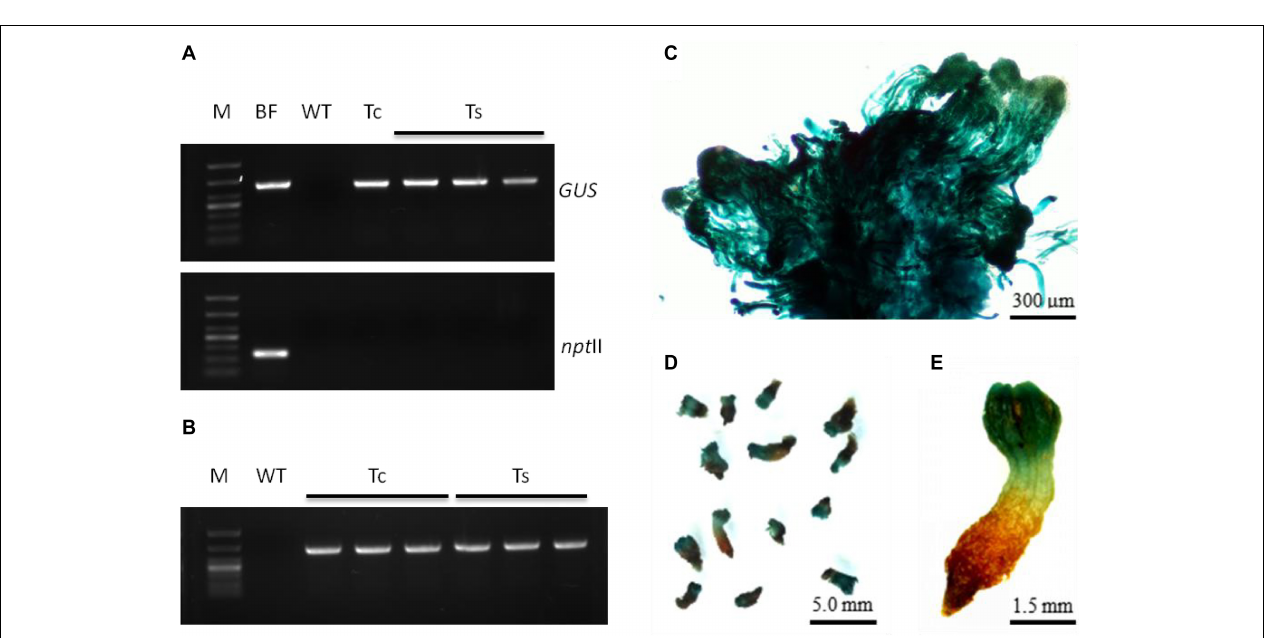
FIGURE 6 | GUS staining in the transgenic L. olgensis embryogenic callus. GUS staining of (a) WT, (b) kanamycin-, and (c) hygromycin-resistant calluses infected with A. tumefaciens GV3101 containing plasmid pBI121 and pCAMBIA1301, respectively. Expression pattern of 35S promoter-driven GUS in embryogenic callus (d) , whole embryogenic suspended mass (e) , and embryogenic cells (f) . The arrow indicates a chimeric cell mass lacking exogenous GUS gene activity.